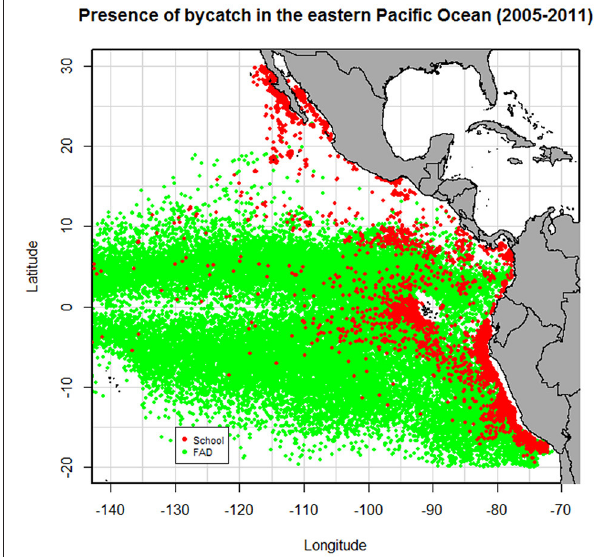
between 2005 and 2011, from which 7894 were School sets and 37174 were FAD sets. The number of sets in both fishing modes is presented in Table 1 and Figure 1